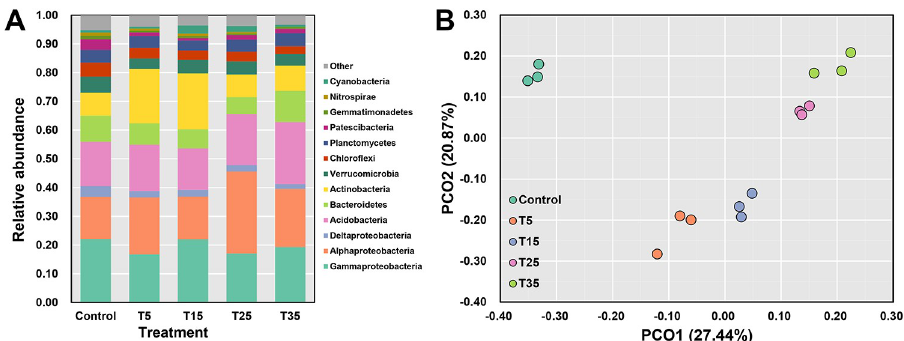
Fig 2. Bacterial community. (A) Rhizosphere bacterial community composition under different temperature. (B) PCoA ordinations of the Rhizosphere bacterial community based on the Bray–Curtis